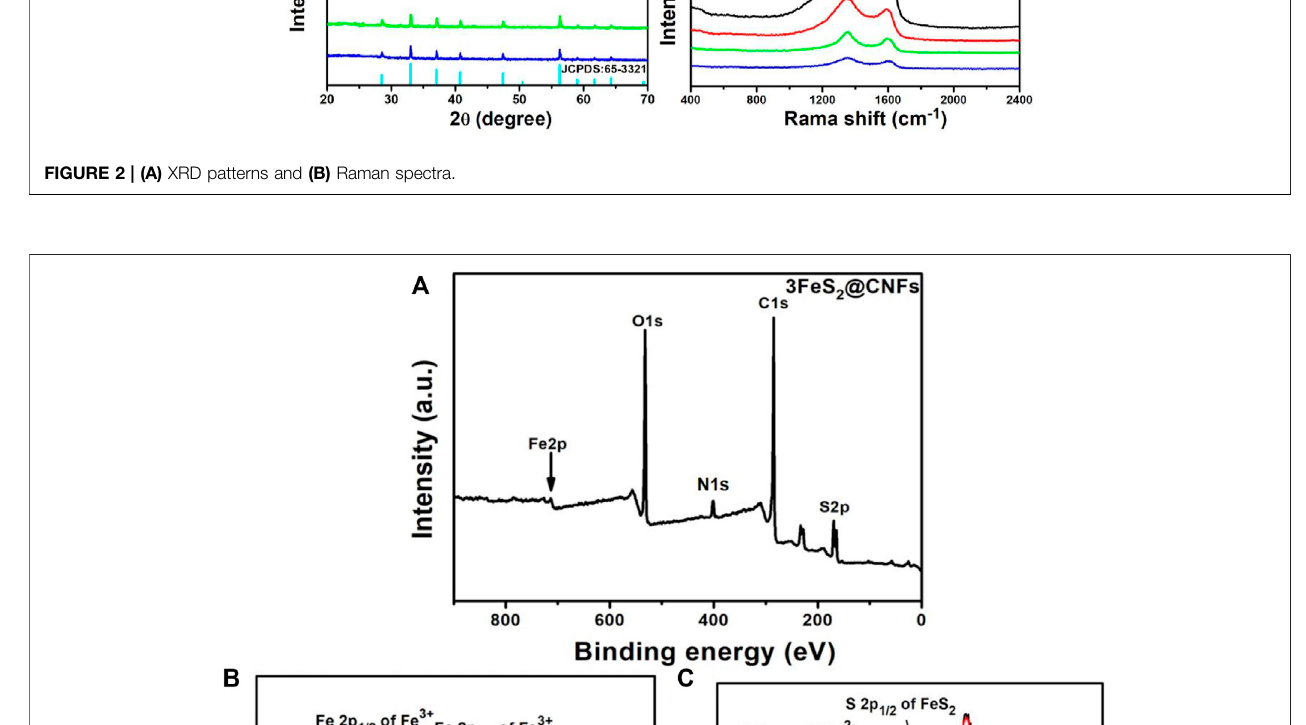
Frontiers in Chemistry |